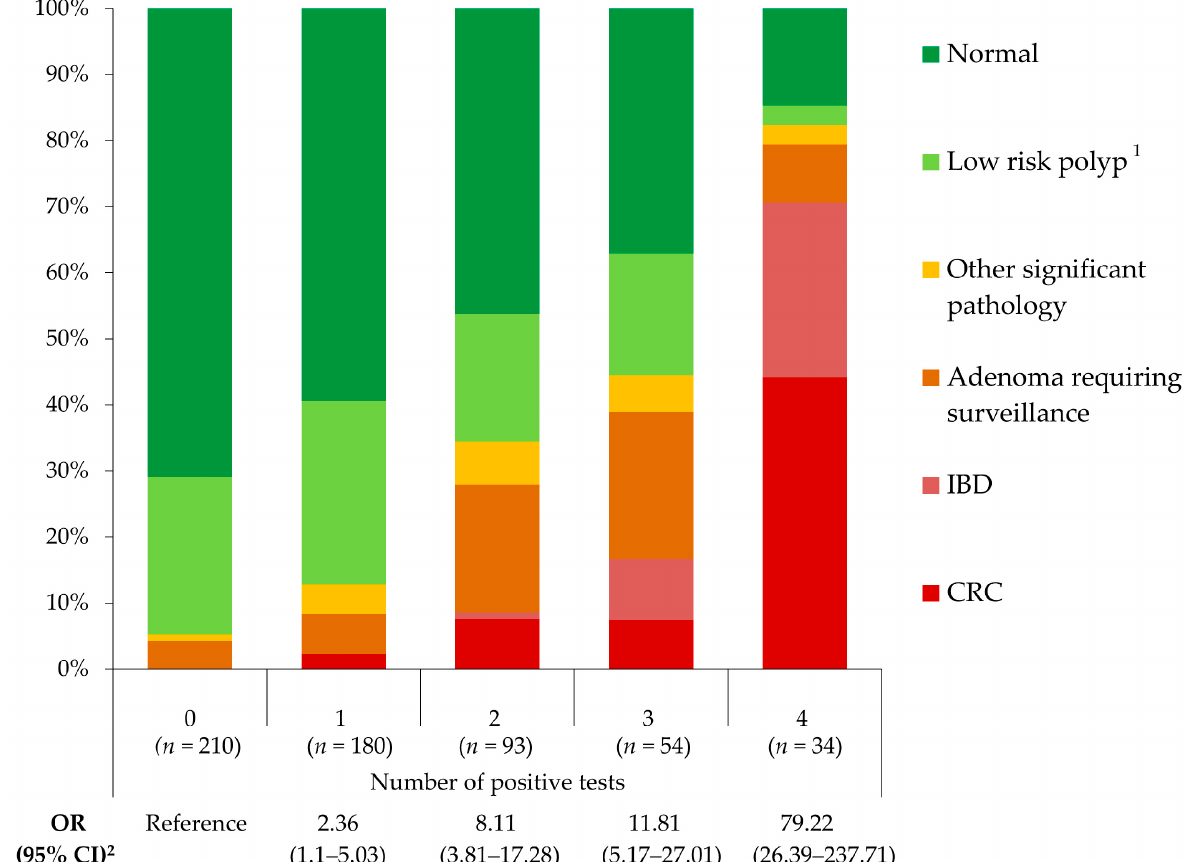
Figure 1. Colonoscopy findings regarding the number of positive results of the four-biomarker combined POC faecal test. 1 Low risk polyp includes adenomas with no indication of follow-up and hyperplastic polyps. 2 OR (95%CI): Odds Ratio (95% confidence interval), risk of presenting significant colonic pathology for each result of the test compared to having the four biomarkers negative, adjusted by age and sex.